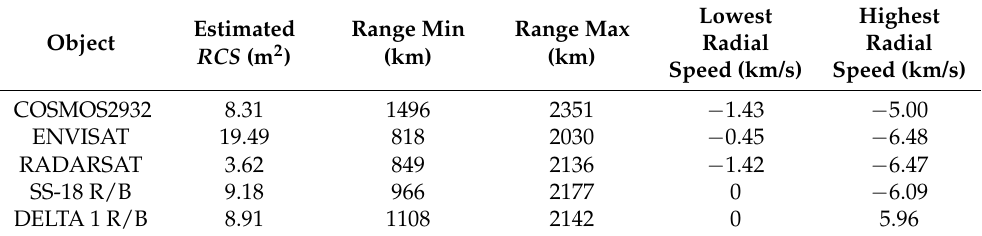
Table 2. Measured ranges and radial speeds for spatial objects targeted during initial tests